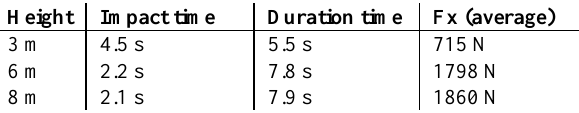
Table 2. Results of the simulation with Fx reporting force of impact in Newtons for each height of the water wall.